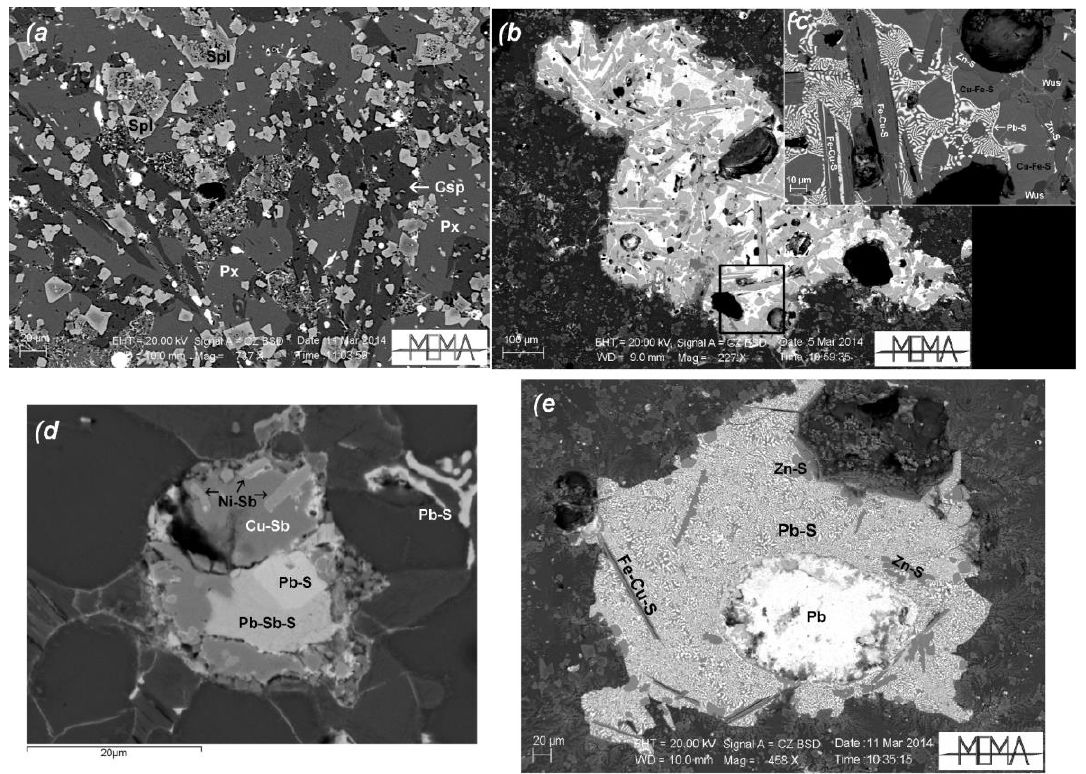
Figure 5. BSE images of Ca-rich matte slags from Montieri: ( a ) panoramic view with pyroxenes, cuspidine, and zoned spinels, ( b ) particular of a matte/speiss inclusion with many metallurgical sulfides and metals, enlarged in ( c ); ( d ) matte/speiss inclusion with Cu-Sb and Ni-Sb phases; ( e ) Pb droplet surrounded by matte. Abbreviations: Px—pyroxenes; Csp– cuspidine; Wus—wüstite; Spl—zoned